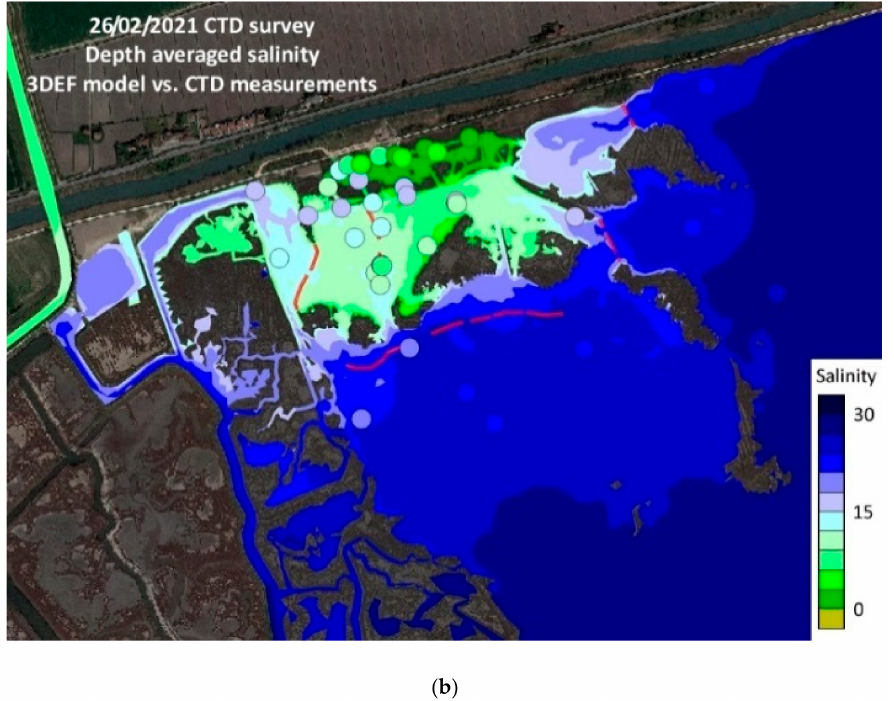
Figure 12. 23 February–9 March 2021 simulation. ( a ) Comparison of daily averaged salinity computed and measured at moored probes; ( b ) map of depth-averaged salinity obtained by model results and by CTD measurements of 26 February 2021.